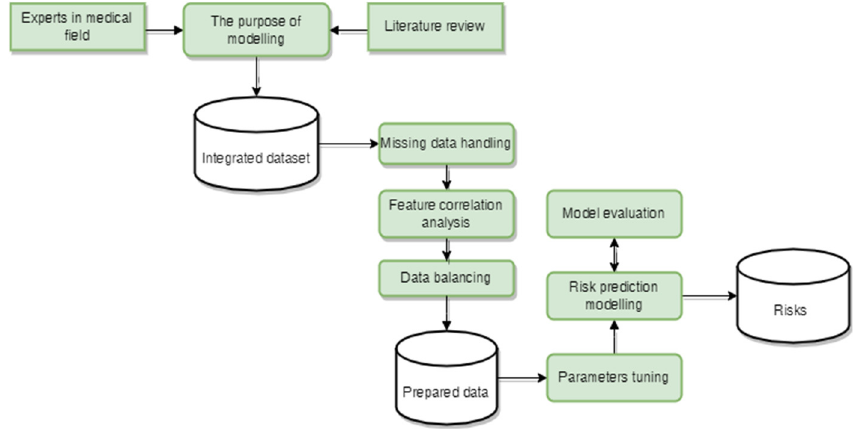
Figure 1. The pipeline for medical risk model development.